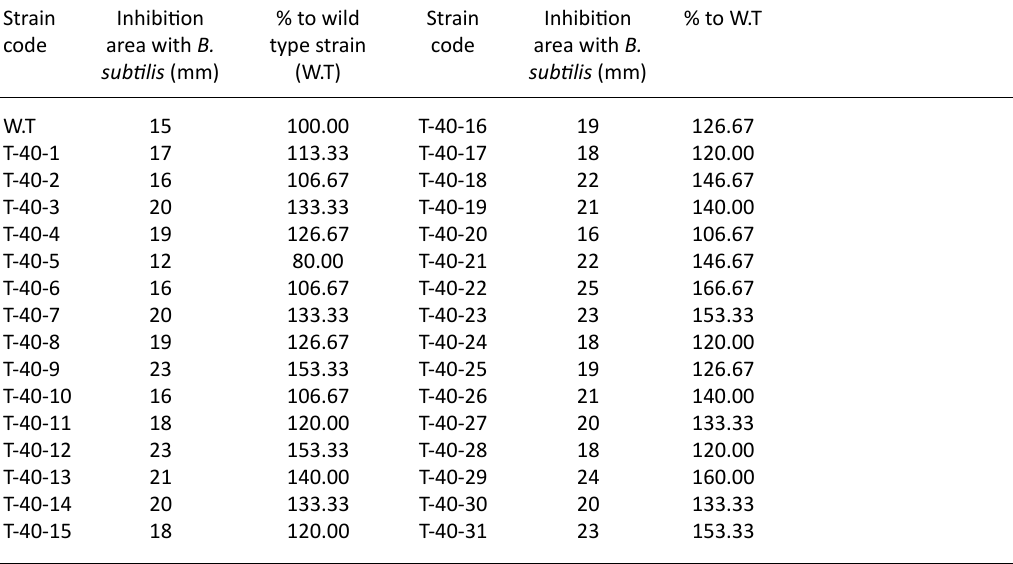
Fig. 2. DNA amplified banding profiles using primer (R1) based on RAPD for three Superior mutants (Lanes 2 to 4) and S. albogriseolus W.T (lane 1) opposite to Sizer™ -1000 plus DNA Marker (lane M). Superior mutants sequence as follows: T-40-22, T-40-29 and Table 4. Neomycin production of different mutants obtained under 1.75 mg/ml neomycin stress and treatment of S. albogriseolus with 100 µg/ml NTG for 40 min Strain Inhibition % to wild Strain Inhibition % to W.T code area with B. type strain code area with B. subtilis (mm) (W.T)